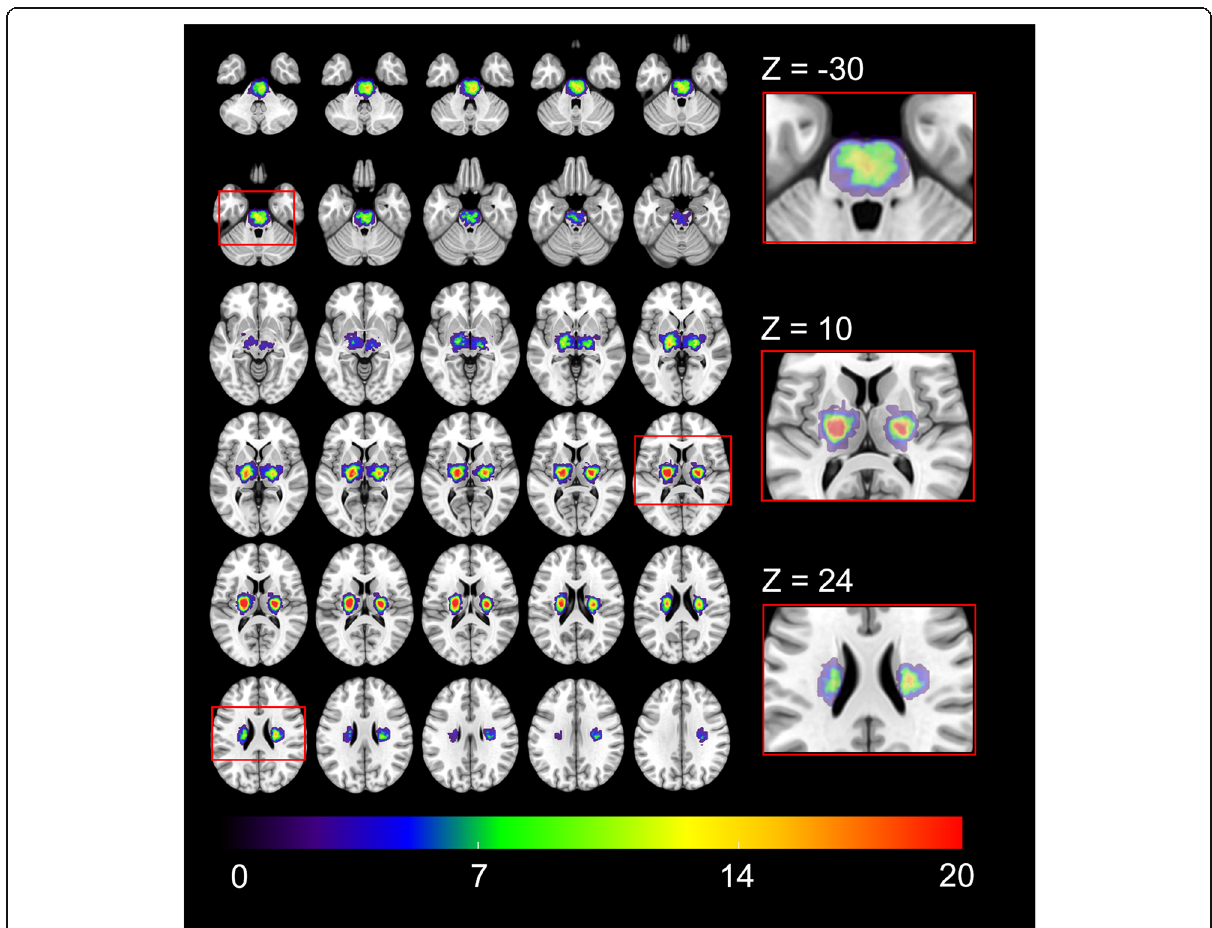
Fig. 1 Probability distribution maps of acute lacunar infarcts. Illustration of the distribution of all lacunar infarcts in the axial plane in a standard